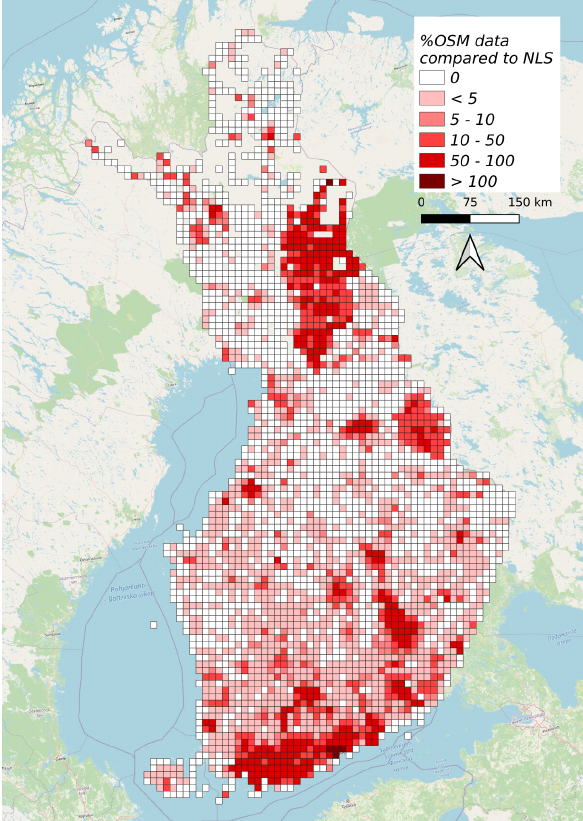
Figure 3: Percentage ratio between the number of OSM and NLS addresses, computed on the 10x10 km EEA